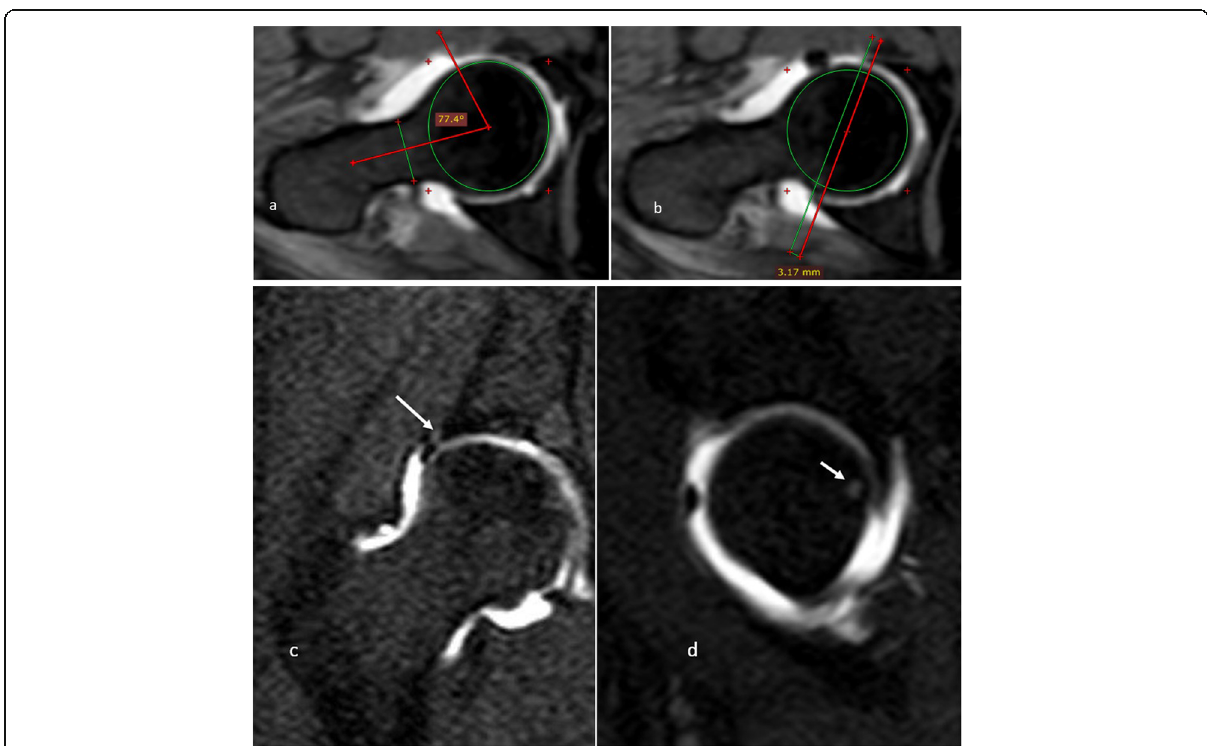
Fig. 7 Femoroacetabular impingement (mixed type) in a 48-year-old female patient, complaining of right hip pain. a , b Axial oblique T1 fat sat post-contrast: a increased alpha angle (77.4°), b increased acetabular depth ( − 3.1 mm). c , d coronal and sagittal T1 fat sat post-contrast: c anterior labral tear detected as high signal contrast across the labrum base (arrow), d irregular outline and non- uniform decreased thickness of posterior cartilage associated with posterior femoral subchondral cyst (arrow)